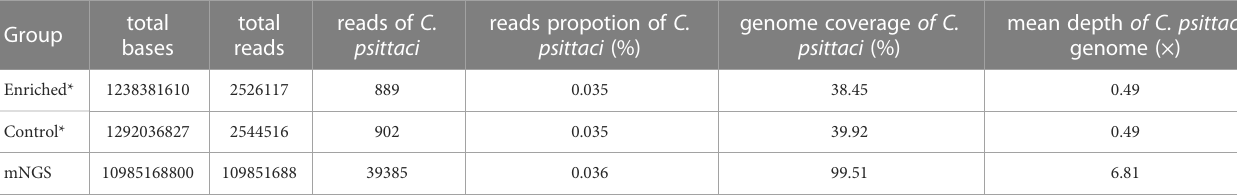
total reads of C. reads propotion of C. psittaci psittaci reads